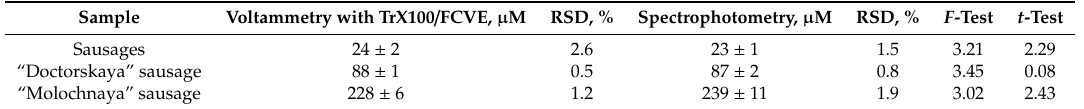
Table 4. Results of NO 2 − determination in sausage extracts applying the TrX100 / FCVE and the UV-spectroscopic method ( n = 3, p =